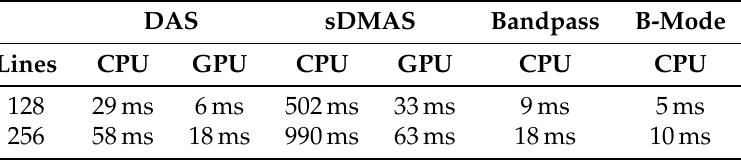
Table 3. Runtime of our DAS and sDMAS implementations, processing one frame. The standard deviations of the runtimes are each smaller than 5% of the listed means. Choice of apodization had no impact on the runtime. The Tukey window bandpass as well as the B-Mode envelope detection were exclusively performed on CPU. DAS sDMAS Bandpass B-Mode